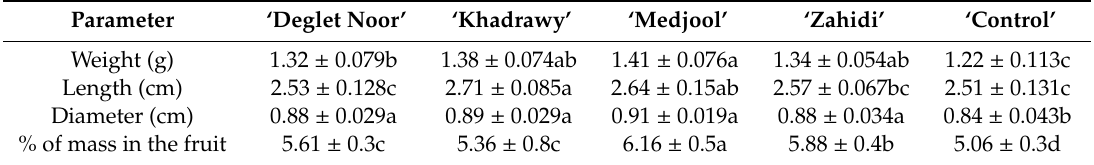
Table 1. Physical characteristics of ‘Medjool’ date seeds obtained from fruit resulting from pollination using pollen from ‘Deglet Noor’, ‘Khadrawy’, ‘Medjool’, and ‘Zahidi’ cultivars. Control is a pollen mixture from random date palm male plants used by the